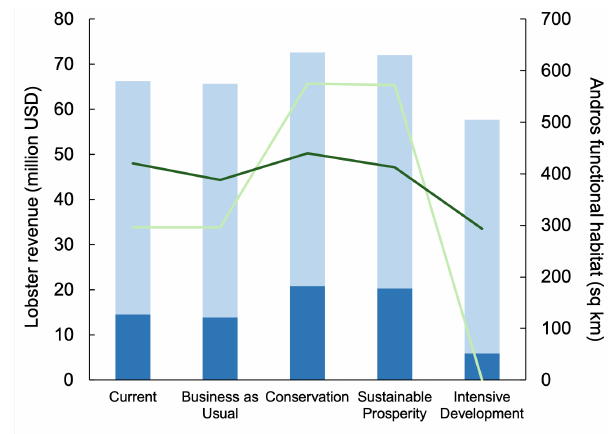
Fig. 6 . Modeled revenue from lobster attributable to Andros nursery habitat and the rest of The Bahamas (bars), and functional seagrass and mangrove habitat on Andros (lines) under the current situation and four future development